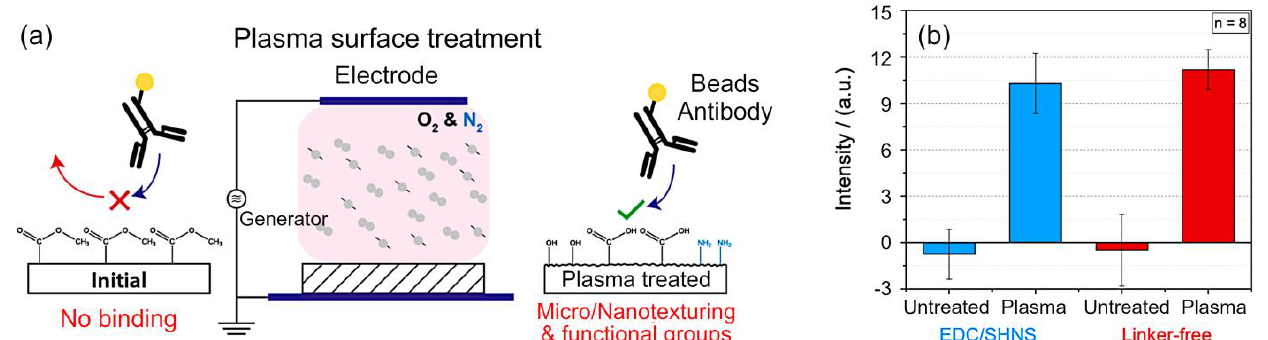
Figure 4. ( a ) Exposure of polymer surfaces to plasma species leads to surface texturing, with features spanning micro and nano-scales, and simultaneous introduction of functional groups with an affinity for biomolecules, where the latter could be selectively immobilized via physical and covalent bonding in the absence of the linker. ( b ) Antibody immobilization on pristine and plasma-treated poly(methyl methacrylate) surfaces: (i) 1-Ethyl-3-(3-(dimethylamino)propyl)carbodiimide/N- hydroxysulfosuccinimide (EDC/sHNS) mediated and (ii) linker-free immobilization of antibodies labelled using Au nanoparticles. The mouse IgG antibodies labelled with two different methods were used. Reproduced from Wieland et al. (2020) [40] under conditions of the CC BY